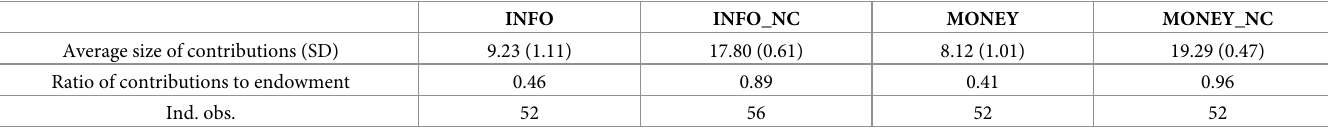
Table 4. Average provision